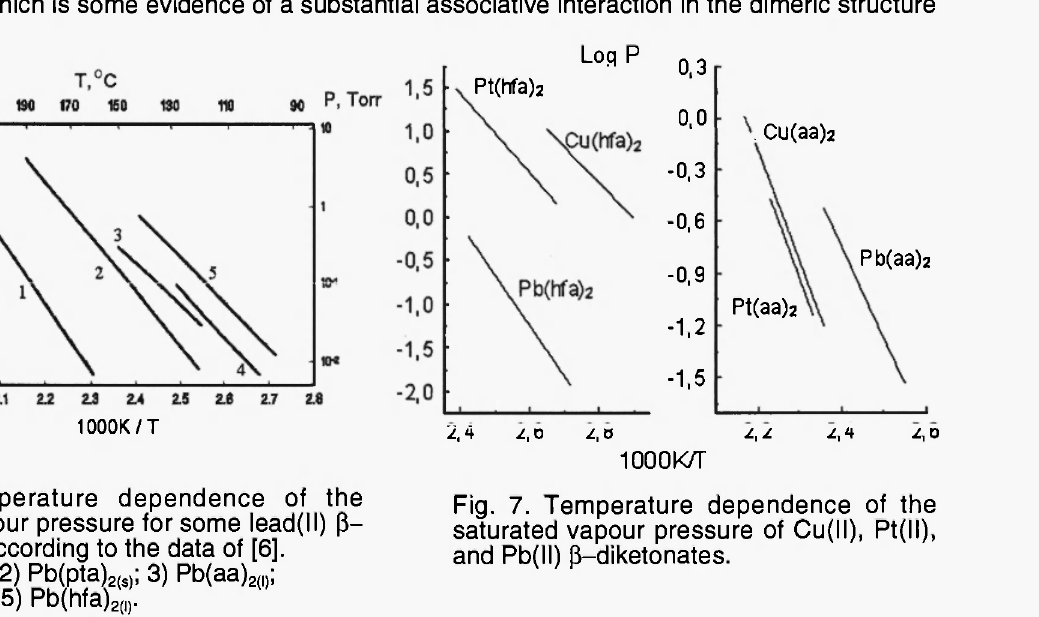
Fig. 7. Temperature dependence of the saturated vapour pressure of Cu(ll), Pt(ll), and Pb(ll)